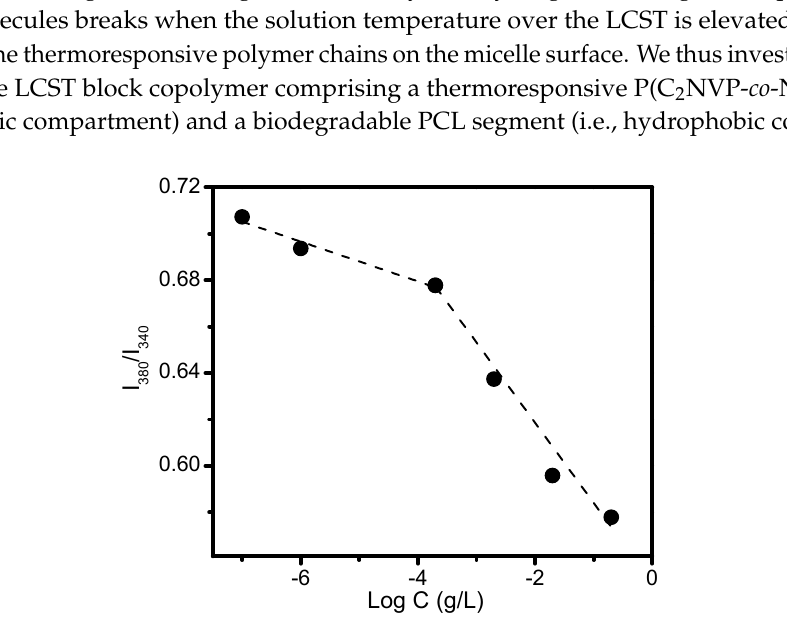
Figure 9. Critical micelle concentration (CMC) examination of P(C 2 NVP- co -NVP)- b -PCL block copolymer by using pyrene as a probe.